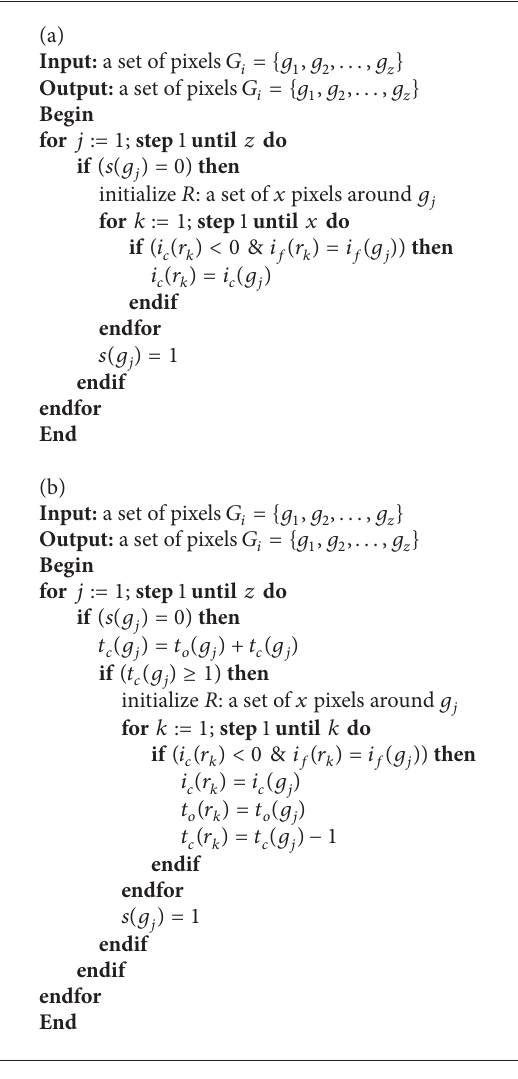
Algorithm 4: (a) PixelsTransformation () for an ordinary SVT. (b) PixelsTransformation () for a weighted SVT.